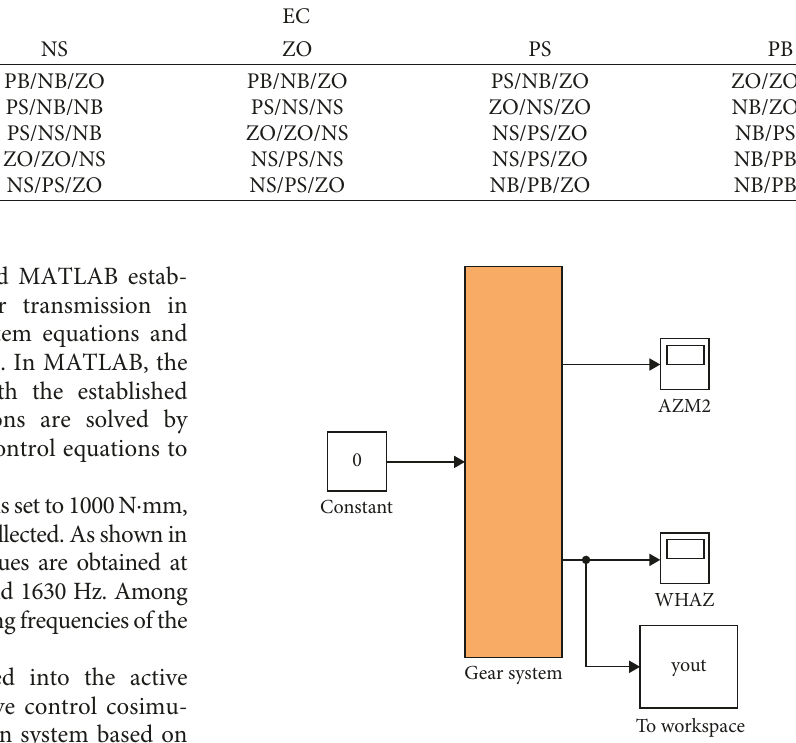
Table 2: Fuzzy rules for K